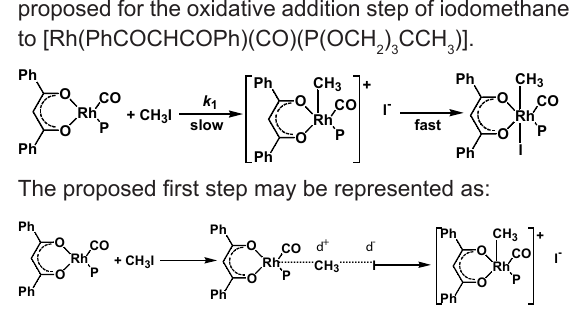
Figure 8. Visualization of selected molecular orbitals of the reactants, transition state (TS) and the Rhodium(III)-alkyl reaction product of the oxidative addition reaction [Rh(PhCOCHCOPh)(CO)(P(OCH of the TS HOMO diagram and the p is as